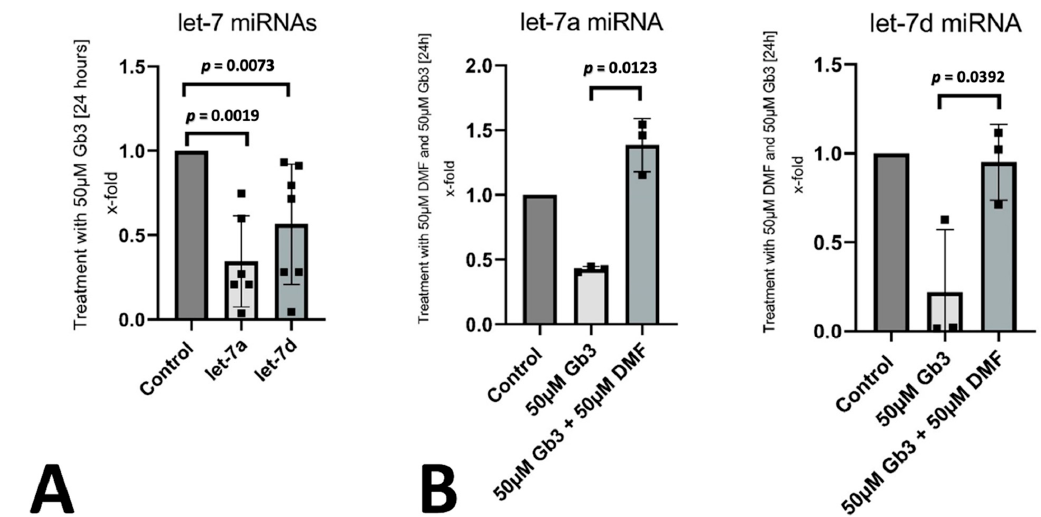
Figure 3. Regulation of let-7a and let-7d in vitro: ( A ) the influence of Gb3 on the expression of let-7a and let-7d was evaluated in endothelial cells. Mean ± standard deviation is depicted with p ≤ 0.05 considered as significant. ( B ) To determine the influence of NF- κ B signaling on let-7a and let-7d expression levels, we used the NF- κ B inhibitor dimethylfumerate (DMF) and evaluated the levels of let-7a and let-7d with and without inhibitor during Gb3 stimulation by qPCR. Mean ± standard deviation is depicted with p ≤ 0.05 considered as significant.